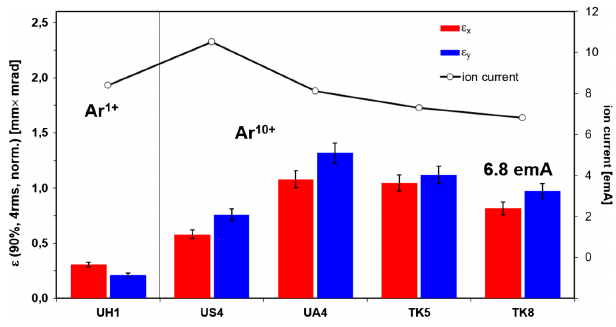
FIG. 11. Evaluation of high-intensity 40 Ar-beam emittance measurements corresponding to Fig.